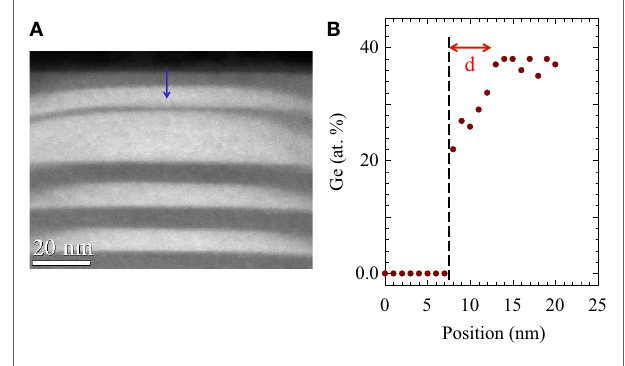
FiGURe 12 | (A) A HAADF-STEM micrograph showing top SiGe cluster layers and EDX scan position (arrow). (B) EDX measured Ge atomic concentration at the topmost Si/SiGe cluster-layer heterointerface. The interface abruptness d is indicated (Modi et al., 2012a).